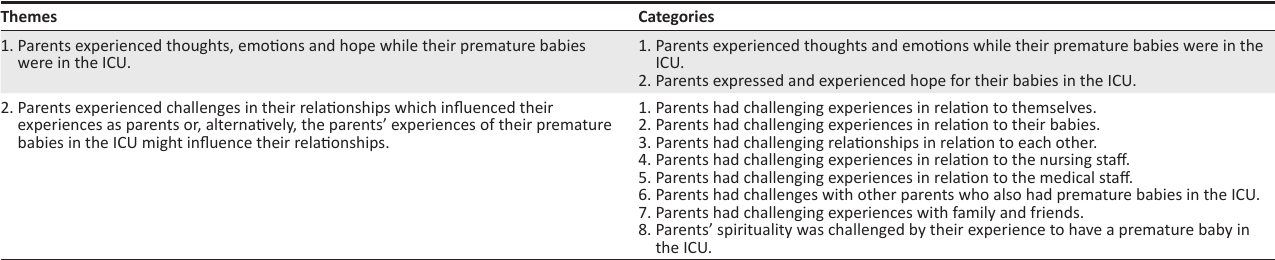
TABLE 1: Themes and categories of parents’ experiences of having a premature baby in the intensive care unit.